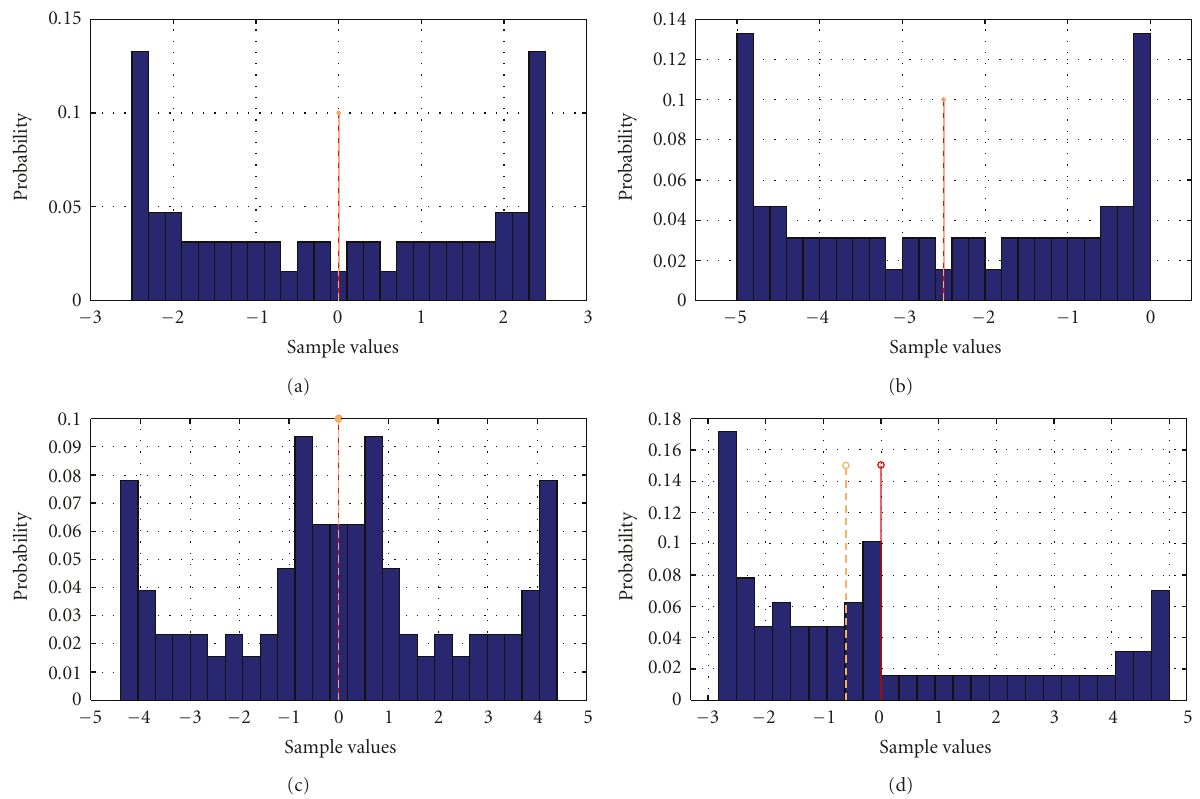
Figure 3: Histograms of R ( p , n ) (left column) and I ( p , n ) (right column) for f p = F ((a) and (b)) PCK RE = PCK IM = 0 . 37, MAD RE = MAD IM = 1 . 77 ((a) and (b)); for f p = 3 F ((c) and (d)), PCK RE = 0 . 19, MAD RE = 1 . 47 (c), PCK IM = 0 . 28, and MAD IM = 1 . 71